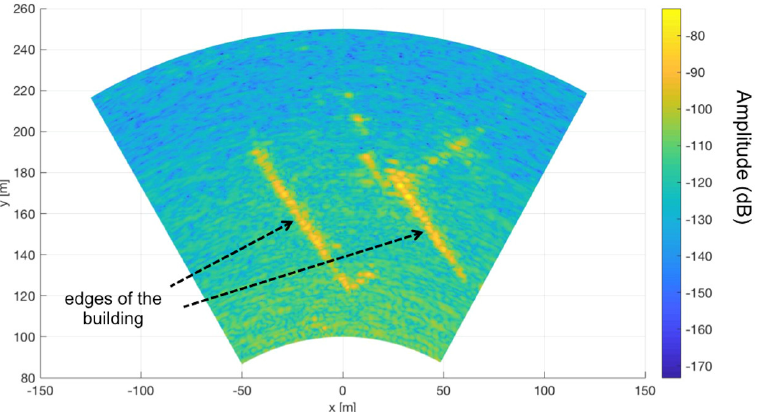
Figure 15. Aerial picture of the seven-storey building used as urban test site.